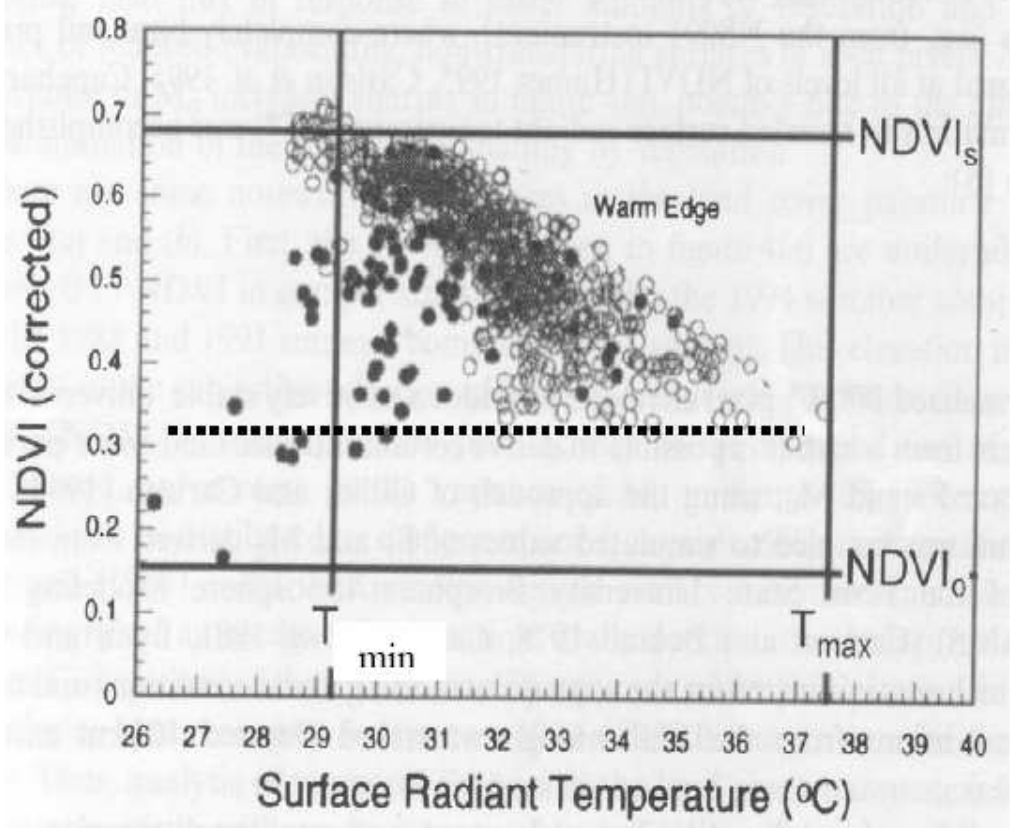
Figure 7. Scatter plot of NDVI versus Tir for an AVHRR image over Central Pennsylvania, 14 June, 1994. Tmax and Tmin, as defined in the text are shown, along with the limits for bare soil NDVI (NDVIo) and that for dense vegetation NDVIs. The horizontal dotted line suggests a possibly better value of NDVIo, than that originally chosen in the article by Owen et al.